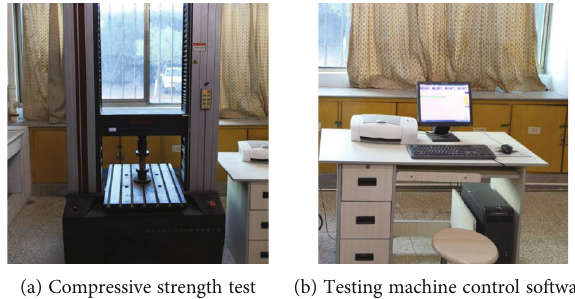
Figure 3: Uniaxial compressive strength test of similar materials. Table 3: Test values of bulk density and uniaxial compressive strength of similar